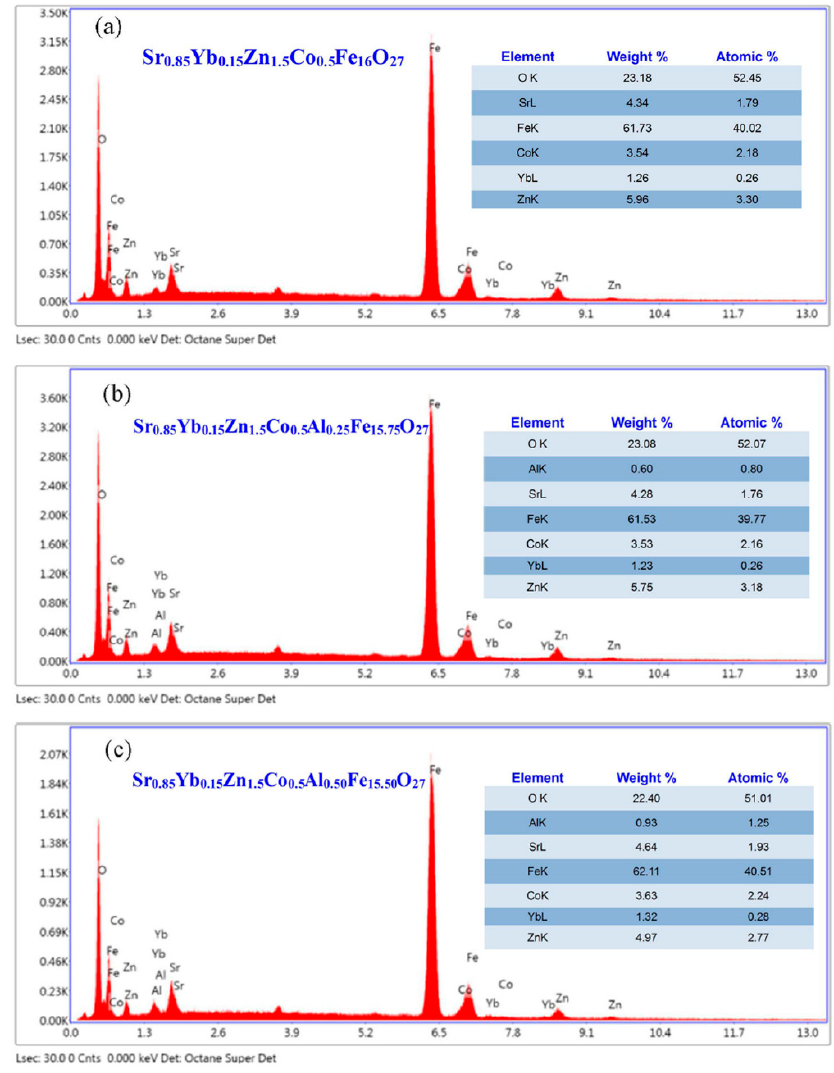
Figure 5. EDX spectra and elemental mapping images of the W-type SrYb hexaferrite Sr 0.85 Yb 0.15 Zn 1.5 Co 0.5 Al x Fe 16-x O 27 with Al content (x) of ( a ) x = 0.00, ( b ) x = 0.25, and ( c ) x = 0.50.